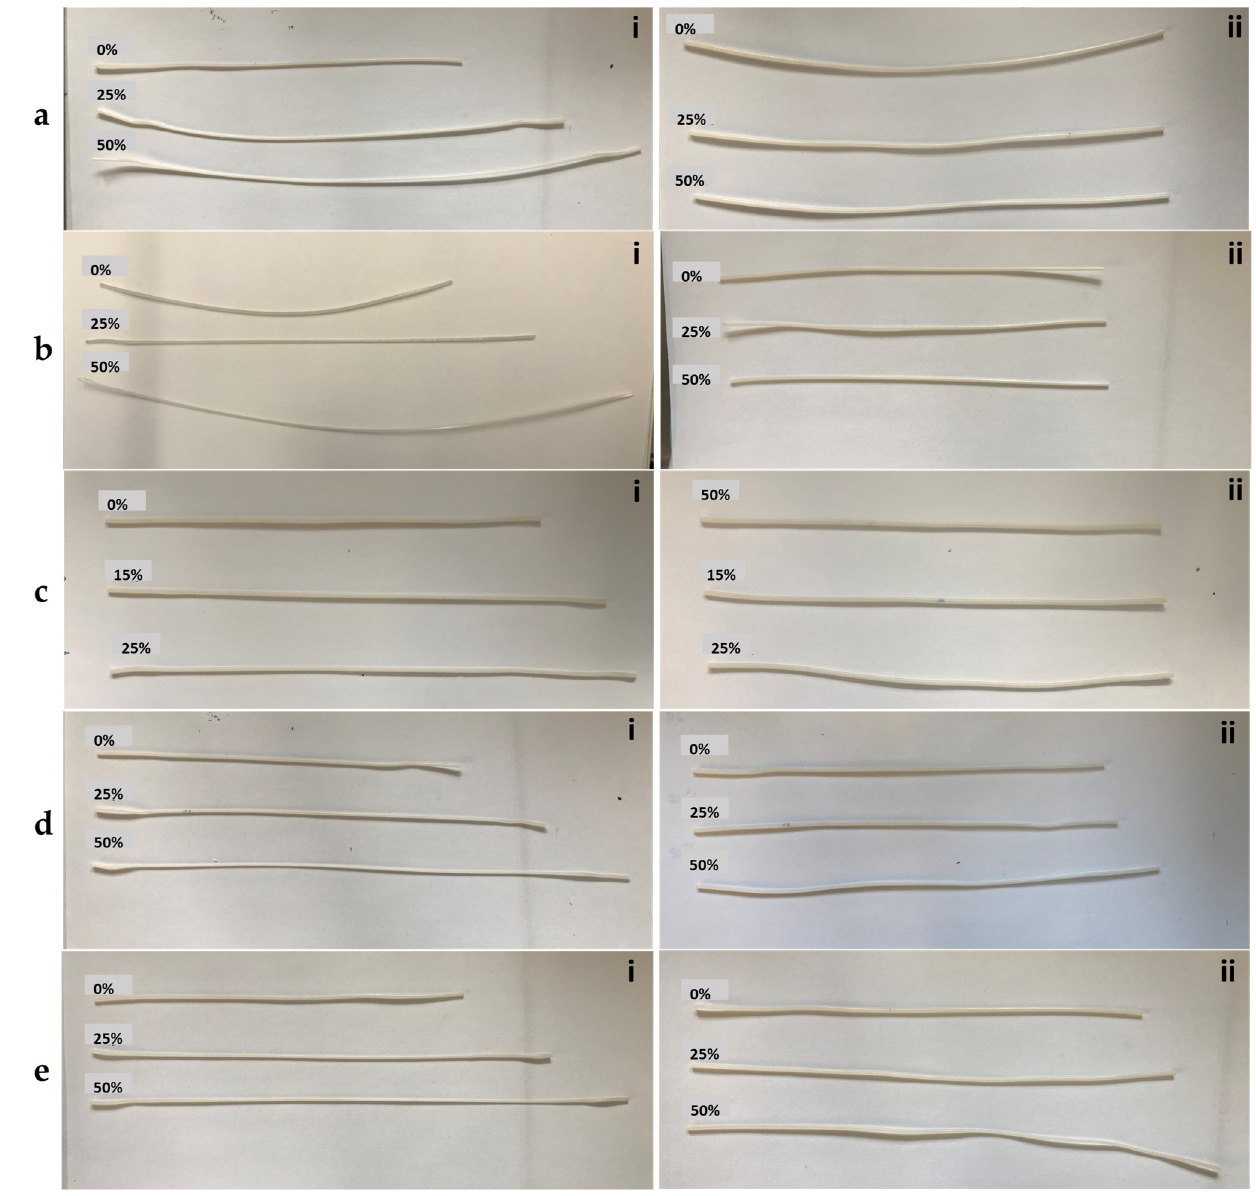
Figure 6. Thermomechanical cycles: ( a ) PLA70PCL30 blend at 0, 25, and 50%: (i) fixing of the temporary shape; (ii) recovery of the permanent shape. ( b ) PLA60PCL40 blend at 0, 25, and 50%: (i) fixing of the temporary shape; (ii) recovery of the permanent shape. ( c ) PLA80PCL20C2.5 blend at 0, 15, and 25%: (i) fixing of the temporary shape; (ii) recovery of the permanent shape. ( d ) PLA70PCL30C5 blend at 0, 25, and 50%: (i) fixing of the temporary shape; (ii) recovery of the permanent shape. ( e ) PLA60/PCL40C5 blend at 0, 25, and 50%: (i) fixing of the temporary shape; (ii) recovery of the permanent shape [30].